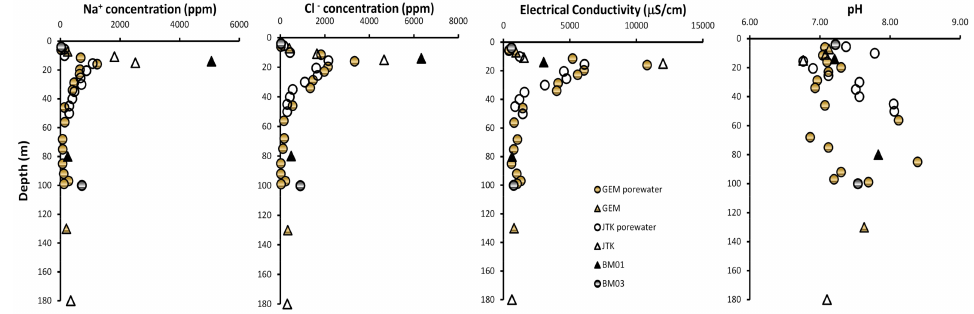
Figure 8. Concentrations of Na + and Cl − ions, electrical conductivity, and pH of Semarang-Demak